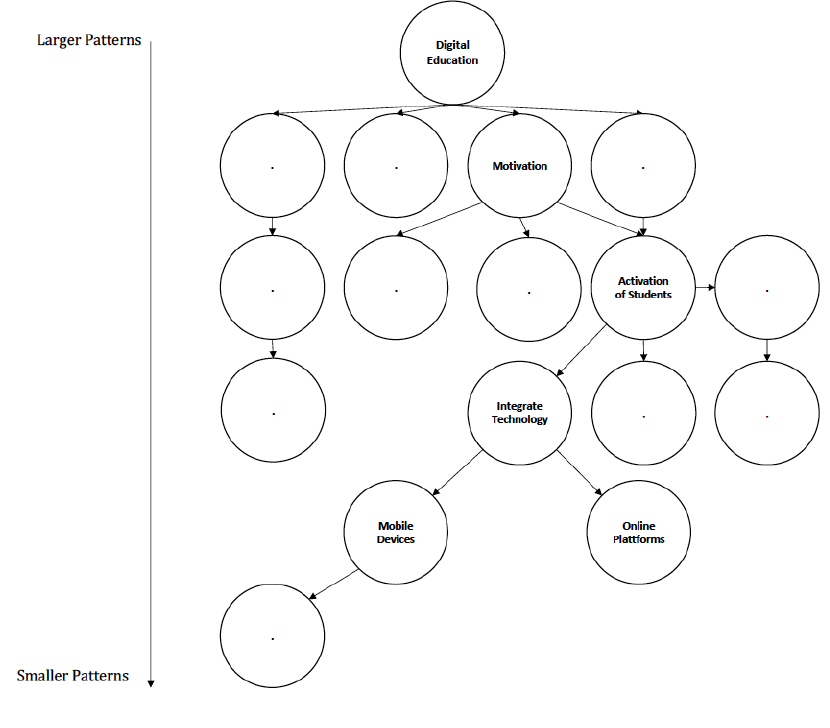
Figure 9. Example pattern